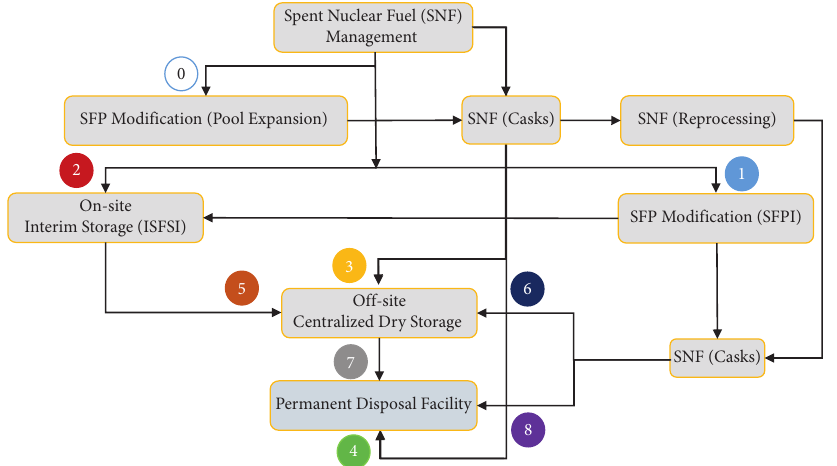
Figure 5: Flowchart of possible spent fuel management strategies for one unit